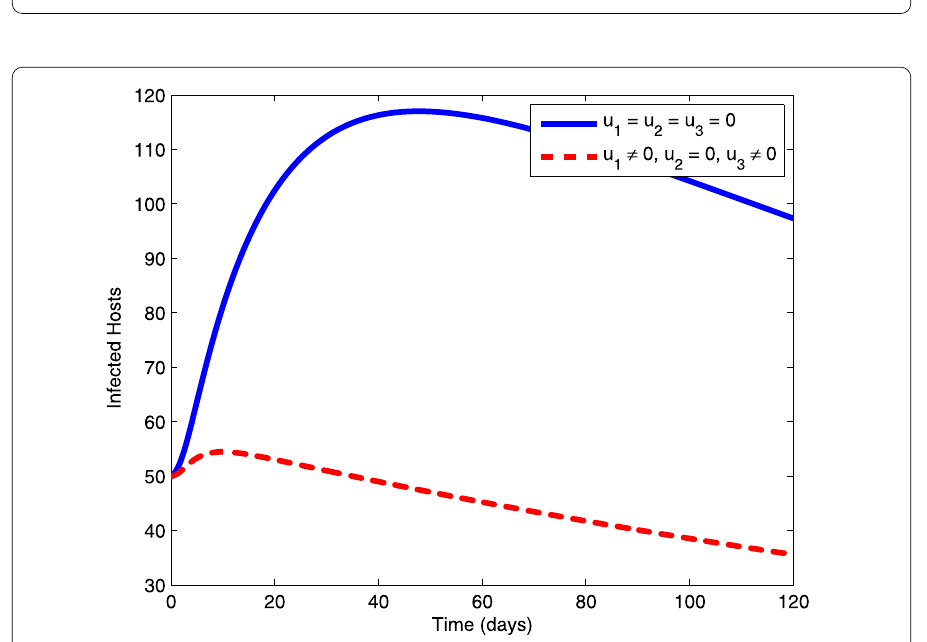
Figure 5 Control Profile.